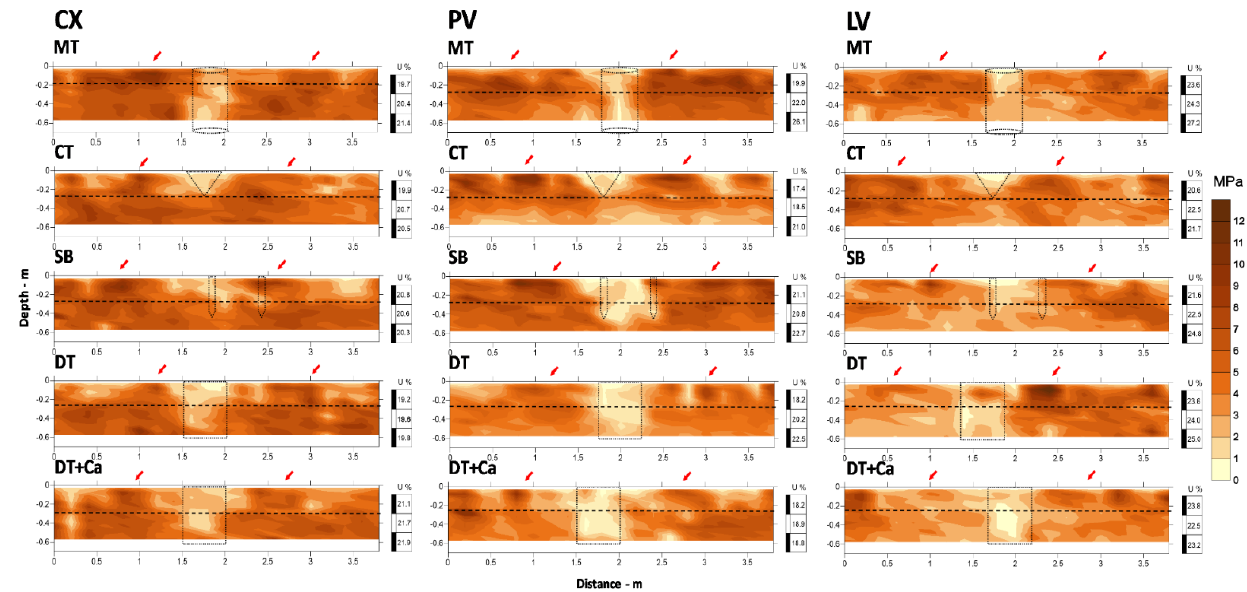
Figure 1. 2D maps of soil resistance to penetration for three soil classes (CX, PV, and LV) under five different soil tillage treatments [MT: minimum tillage with a pit (0.4 m in diameter by 0.7 m deep); CT: conventional tillage (0.25 m deep); SB: subsoiler with booted ripper points on two shanks (0.45 m deep); DT: deep mixing tillage with rotary hoe tiller (0.5 wide by 0.6 m deep); DT + Ca: deep mixing tillage with rotary hoe tiller (0.5 wide by 0.6 m deep) + additional liming. The horizontal dashed line demarcates the working depth of the plow (approximately 0.25 m); dotted lines project the working area of the implements used; red arrows indicate the signs of machine traffic; U: soil moisture based on the weight (U, %) of each layer at the time of data collection. Measurements were performed eight months after tillage operations. Table 1. Physical characterization of the soils of the experimental area.